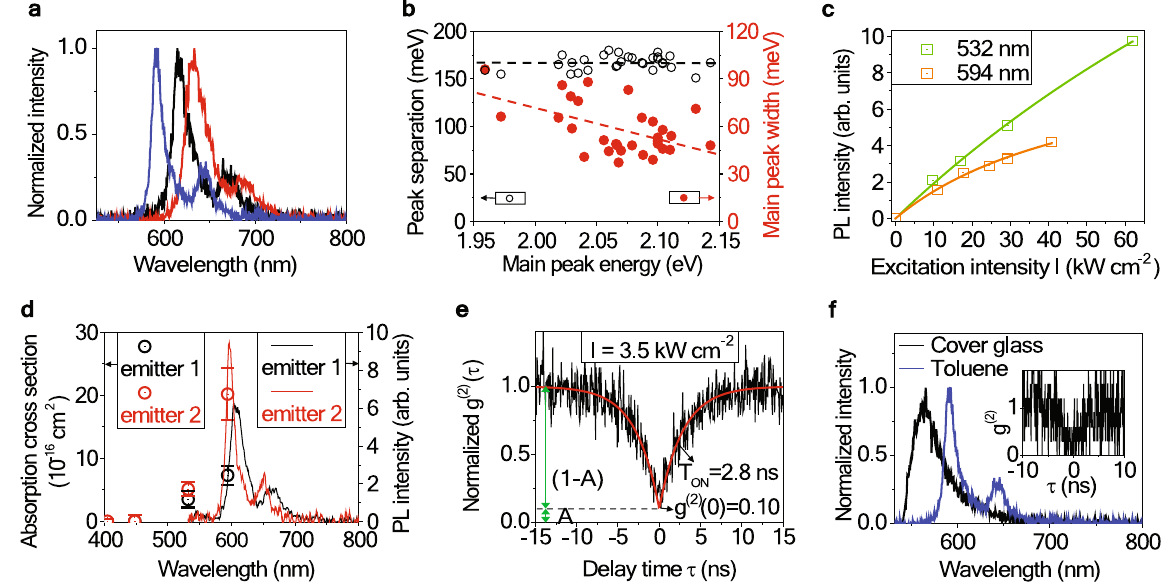
Figure 1. Photoluminescence properties of single emitters from toluene evaporated on cleaned cover glasses. ( a ) The PL spectra of three selected single emitters clearly show two emission peaks. ( b ) The separation between the main and the side peak (black open circles) and the FWHM of the main peak (red solid circles) plotted as a function of the main peak energy. Black dashed line indicates the average value of the peak separation, and the red dashed line is a guide for the eye. ( c ) The PL intensity curves as a function of the pump intensity at excitation wavelengths of 532 nm (green) and 594 nm (orange). Squares are experimental values and solid lines are the fitting. ( d ) Absorption cross section values (open circles with error bars) of two selected emitters. Solid lines are the emission spectra measured at 532 nm excitation. ( e ) Normalized second-order correlation function g (2) ( τ ) at a short time scale (| τ | < 100 ns). g (2) (0) = 0.10 with background subtraction. ( f ) Spectral comparison between the impurities in toluene (blue curve) and in cover glass (black curve). The inset is the g (2) ( τ ) of a defect center in cover